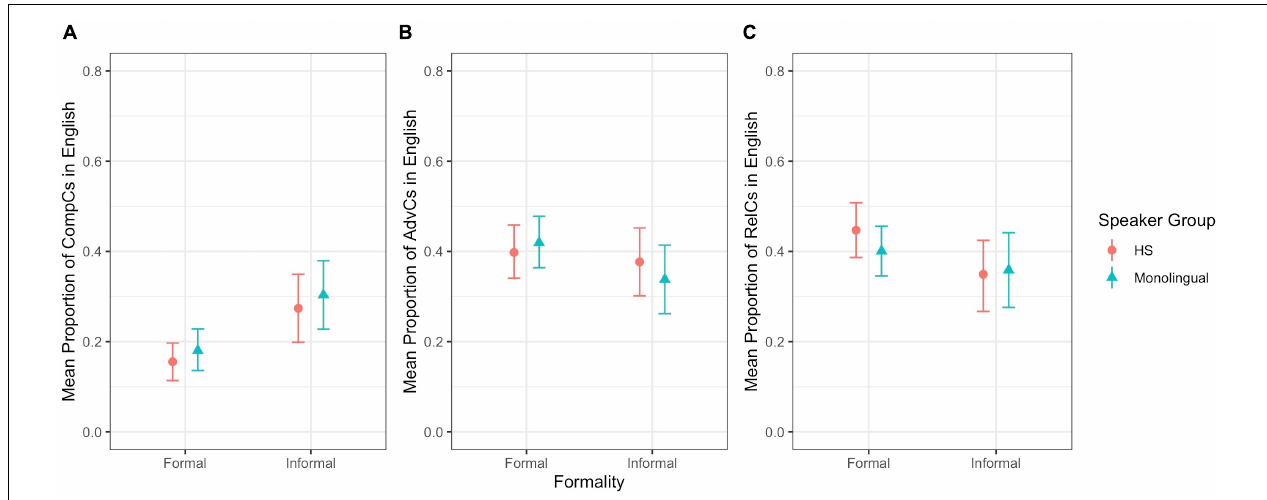
FIGURE 2 | Mean proportion of SC types in English by speaker group and formality: (A) Complement Clauses, (B) Adverbial Clauses, (C) Relative Clauses.